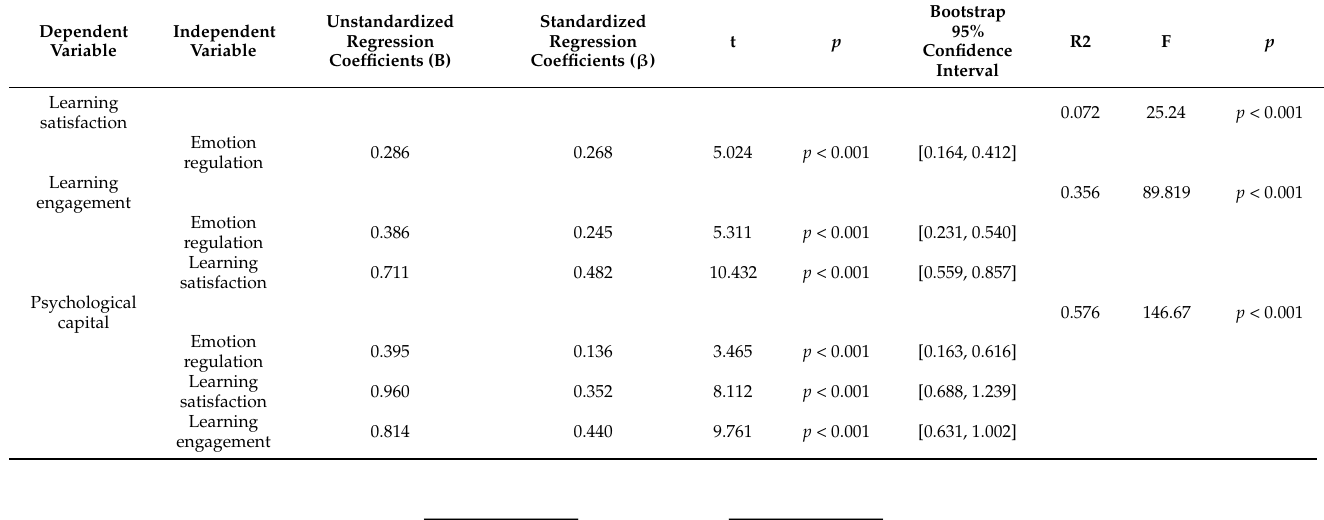
Table 5. Regression analysis results.